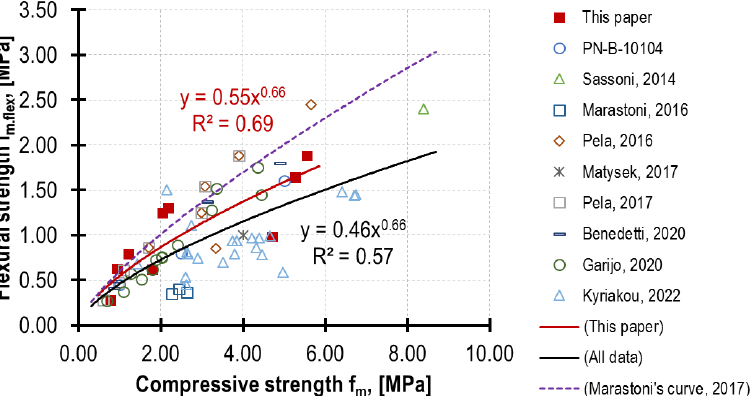
Figure 15. Correlation between mortar compressive strength and mortar flexural strength. Specimens prepared and tested according to EN 1015-11 [6]. Comparison between author’s test results and results from the literature [3,35,41,44–48].